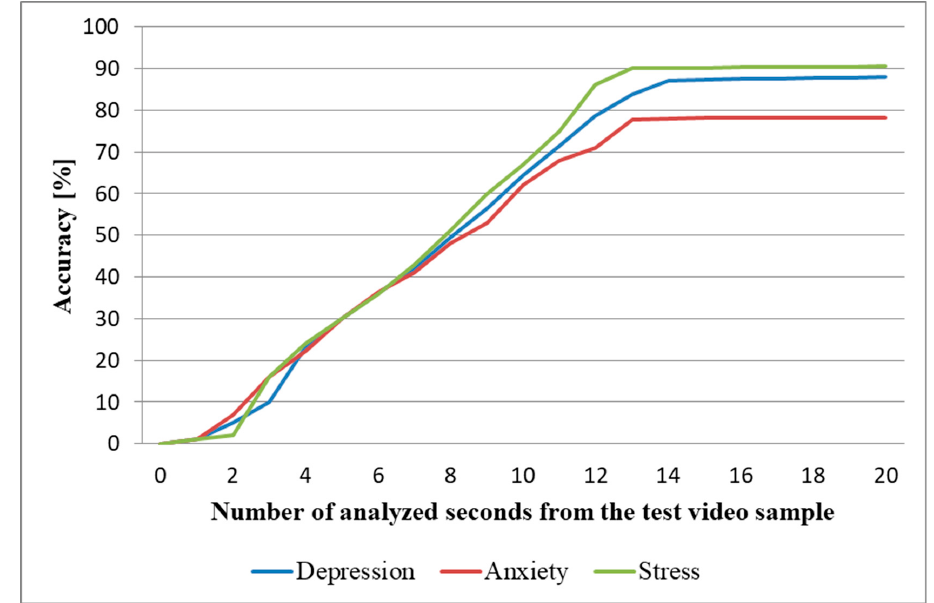
Figure 11. Prediction accuracy based on the number of seconds analyzed from the test video samples (intrasubject methodology).